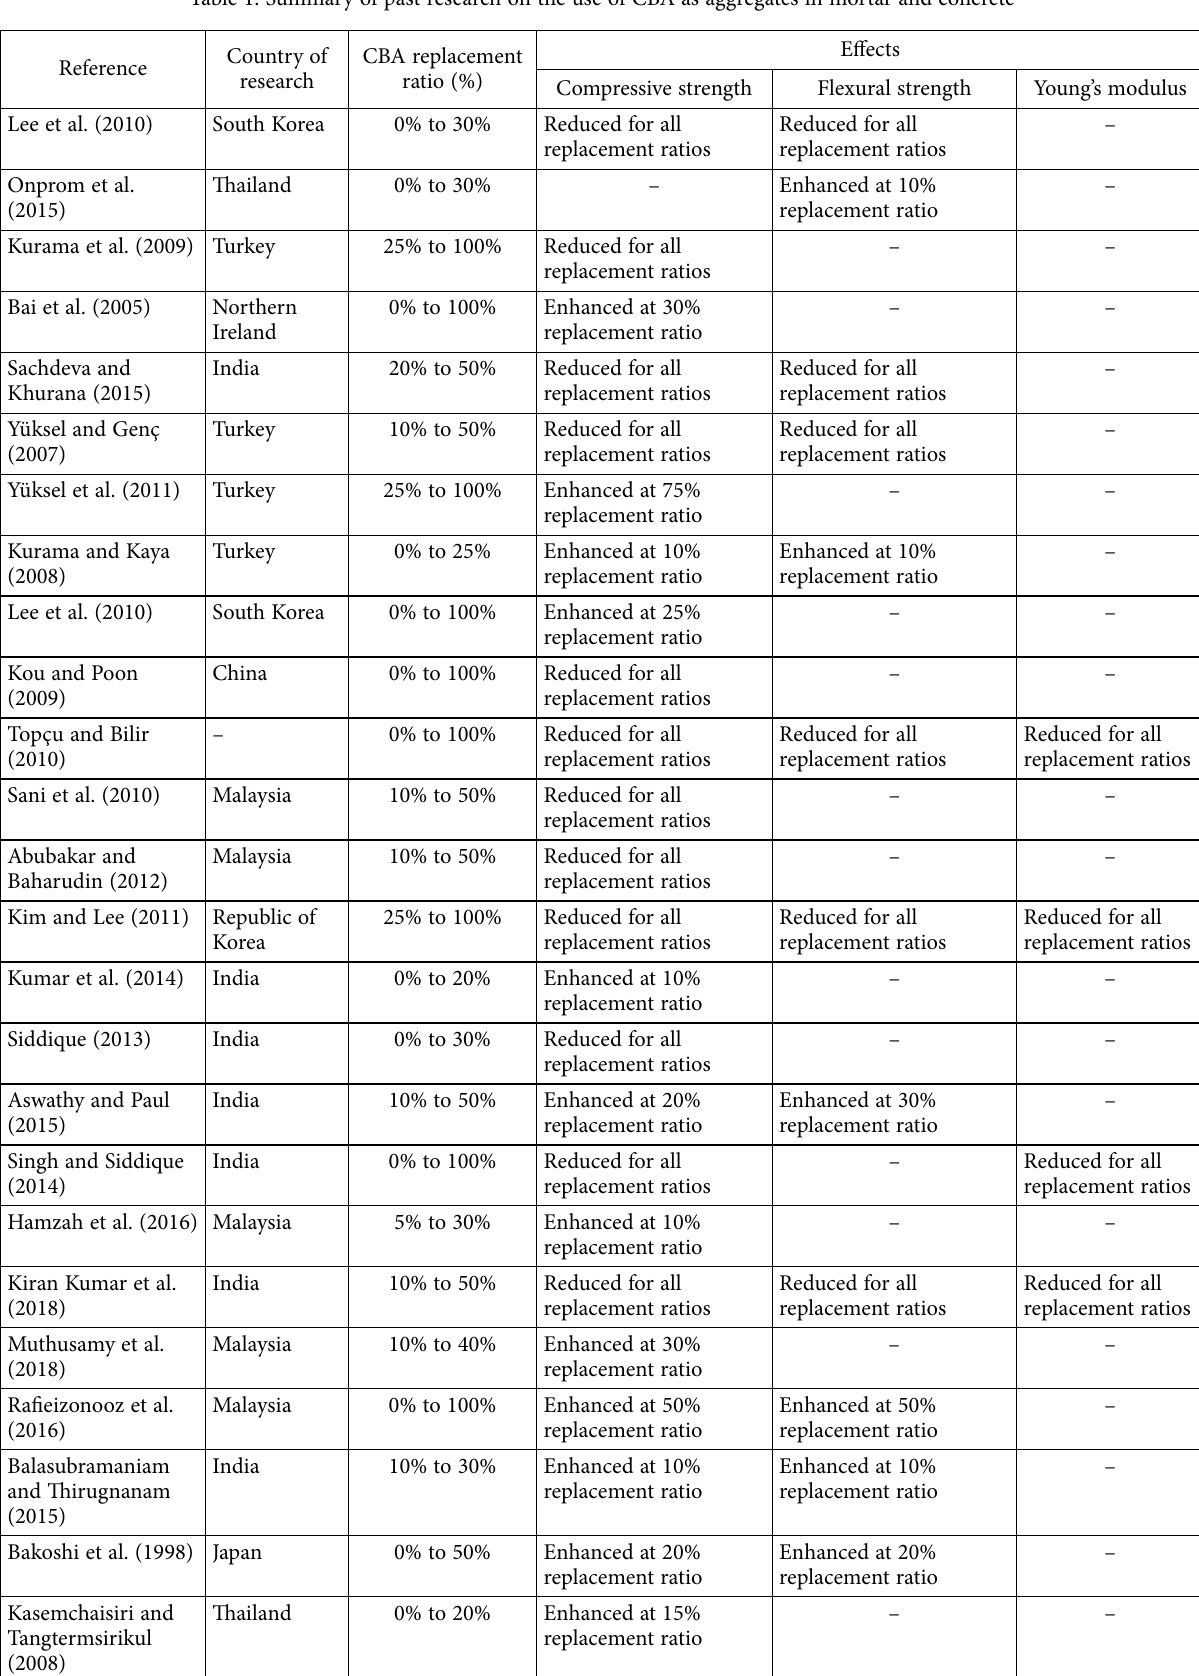
Table 1. Summary of past research on the use of CBA as aggregates in mortar and